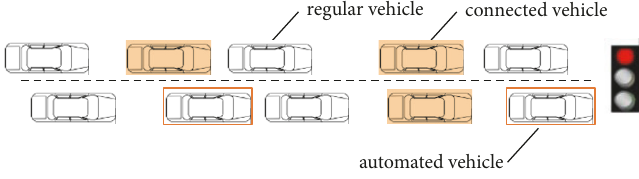
Figure 3: Multimodal traffic streams consisting of RVs, CVs, and